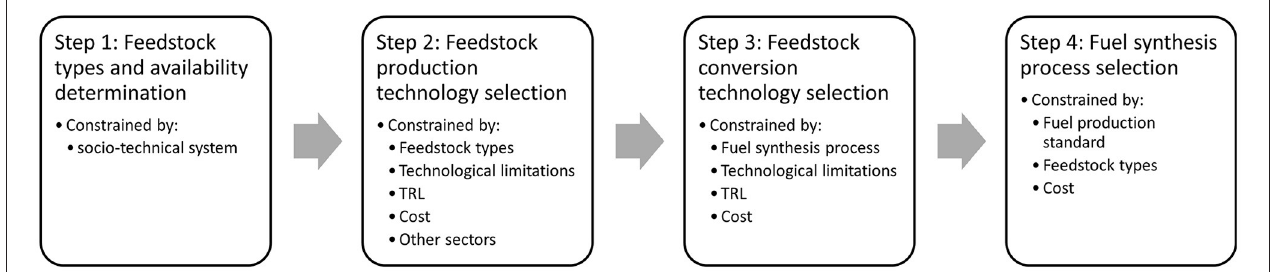
FIGURE 1 | Proposed four steps of selecting SAF technology